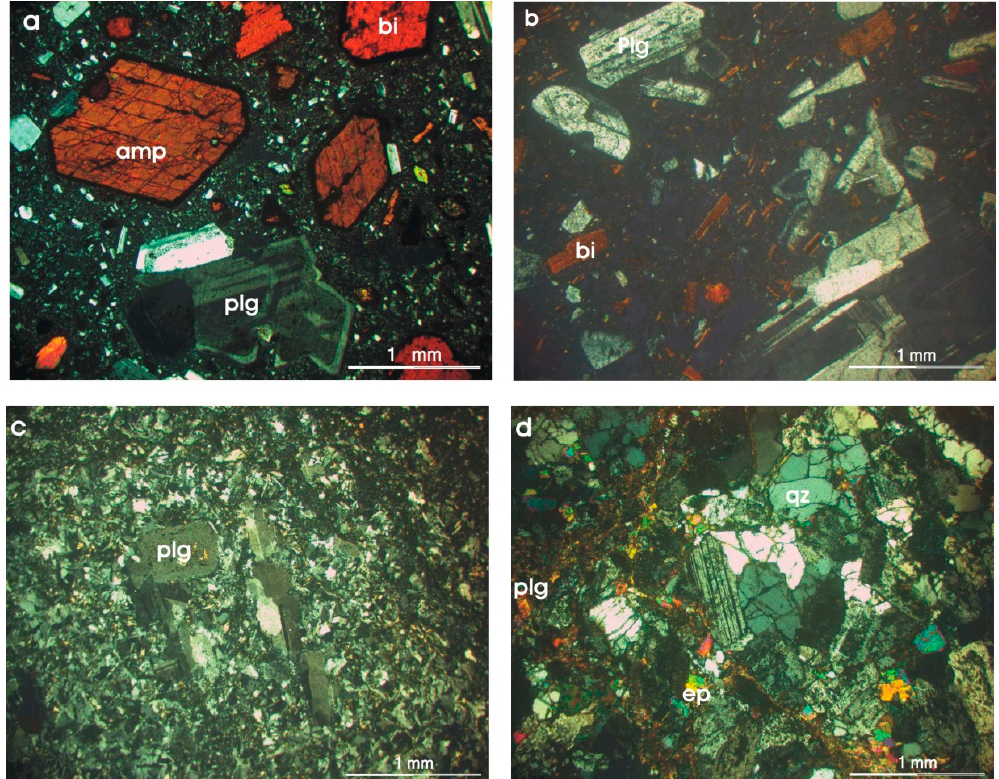
Figure 6. Photomicrographs of representative intermediate-acidic aggregate rocks (XPL): ( a ) phenocrysts of hornblende, biotite, and plagioclase in a porphyritic andesite (sample BE.81). ( b ) phenocrysts of plagioclase and lesser biotite in a porphyritic dacite (sample GE.23). ( c ) granular texture in albitite (sample BE.150). ( d ) granular texture of granodiorite with crystals of plagioclase, quartz, and secondary epidote (sample BE.139). Abbreviations: amp: amphibole, bi: biotite, plg: plagioclase, qz: quartz, ep: epidote.